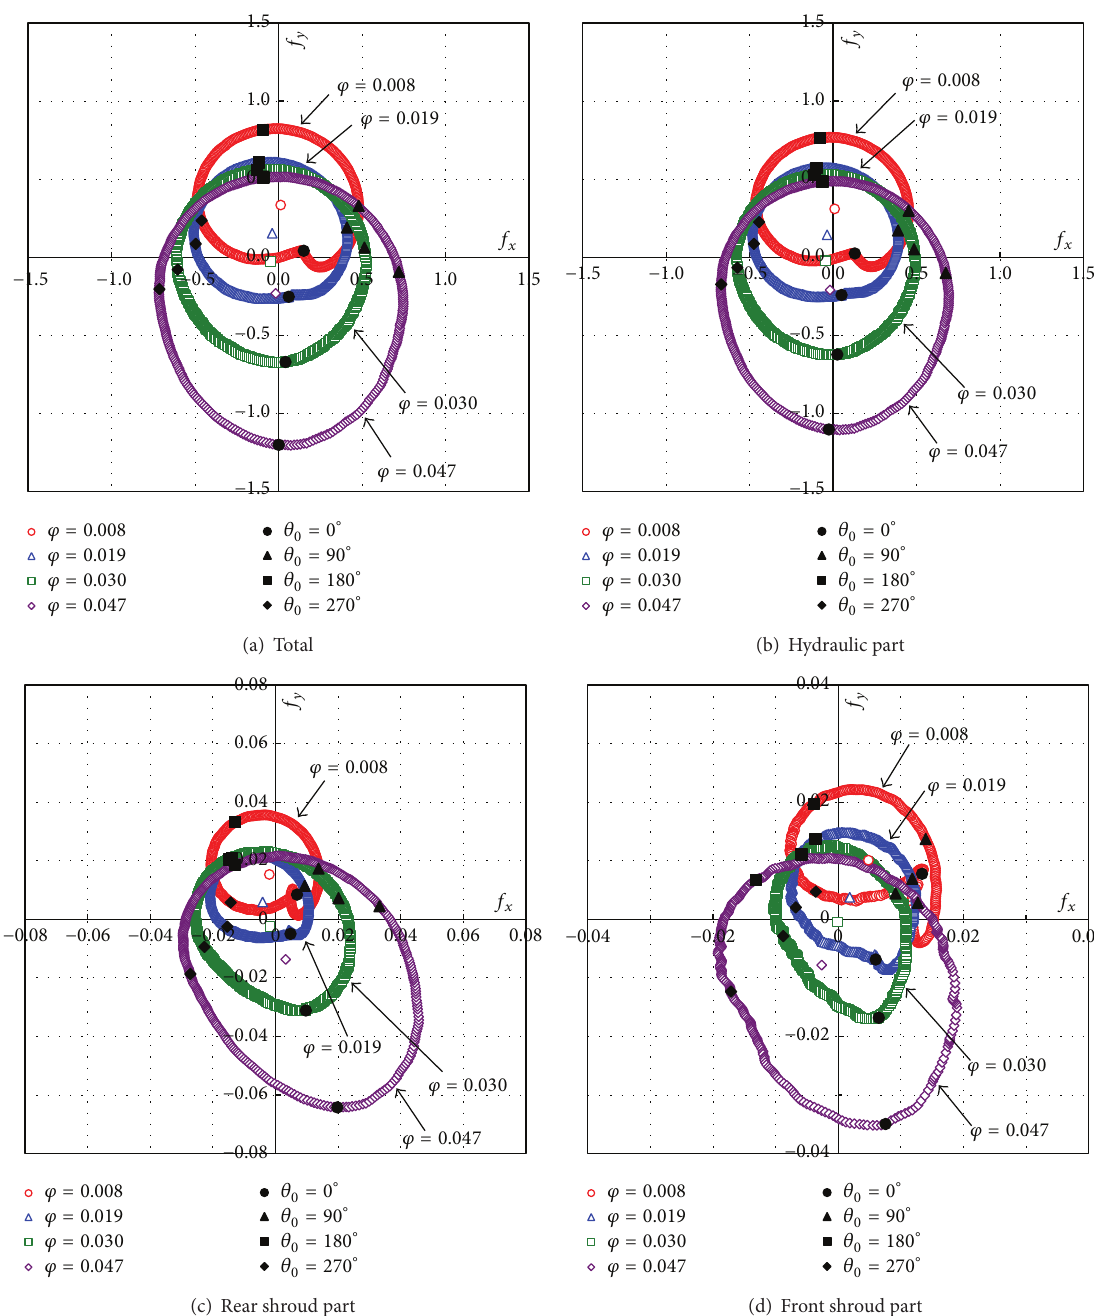
Figure 7: Lissajous figures of radial thrust coefficient on each part ( 𝛽 𝑏2 = 24 ).